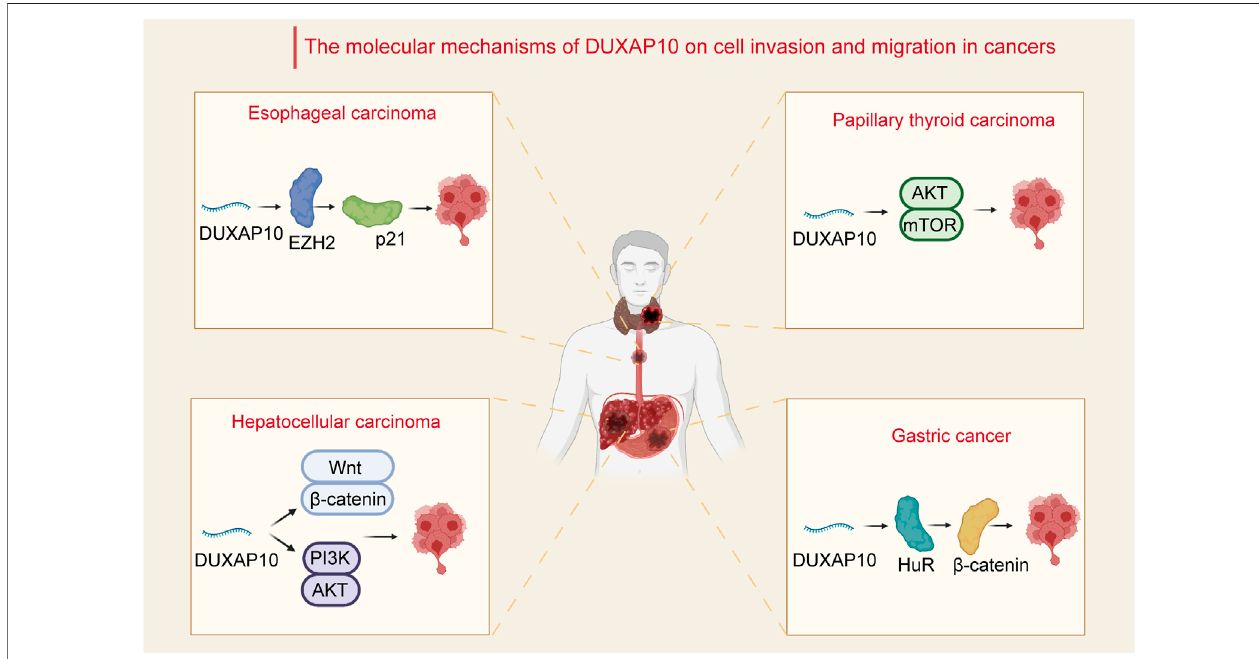
FIGURE 1 | Relevant molecular mechanisms of DUXAP10 in the process of cell invasion and migration in cancers. In hepatocellular carcinoma, DUXAP10 enhances cell invasion and migration through the Wnt/ β -catenin and PI3K/Akt signaling pathways. In papillary thyroid carcinoma, DUXAP10 mediates the activity of the Akt/mTORpathwaytoregulatecancercellinvasionandmigration.Ingastriccancer,DUXAP10isinvolvedintheregulationofinvasionandmigrationviacombinationwith the RNA-binding protein HuR and subsequently increases the stability of β -catenin. In esophageal carcinoma, DUXAP10 regulates cell metastasis by binding with EZH2 and inhibiting p21 expression.